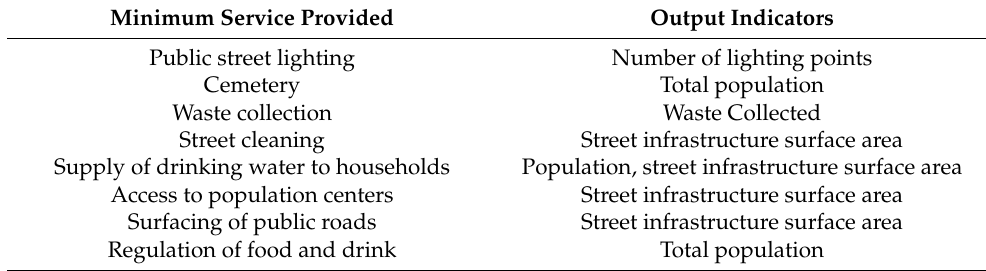
Table 2. Output indicators based on the minimum services required.